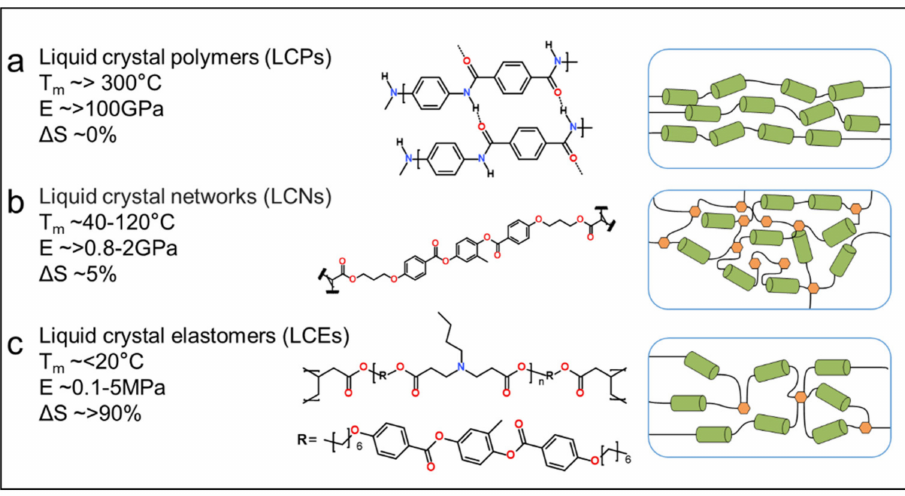
Figure 2. Notional properties and molecular configurations of LCPs ( a ), LCNs ( b ), and LCEs ( c